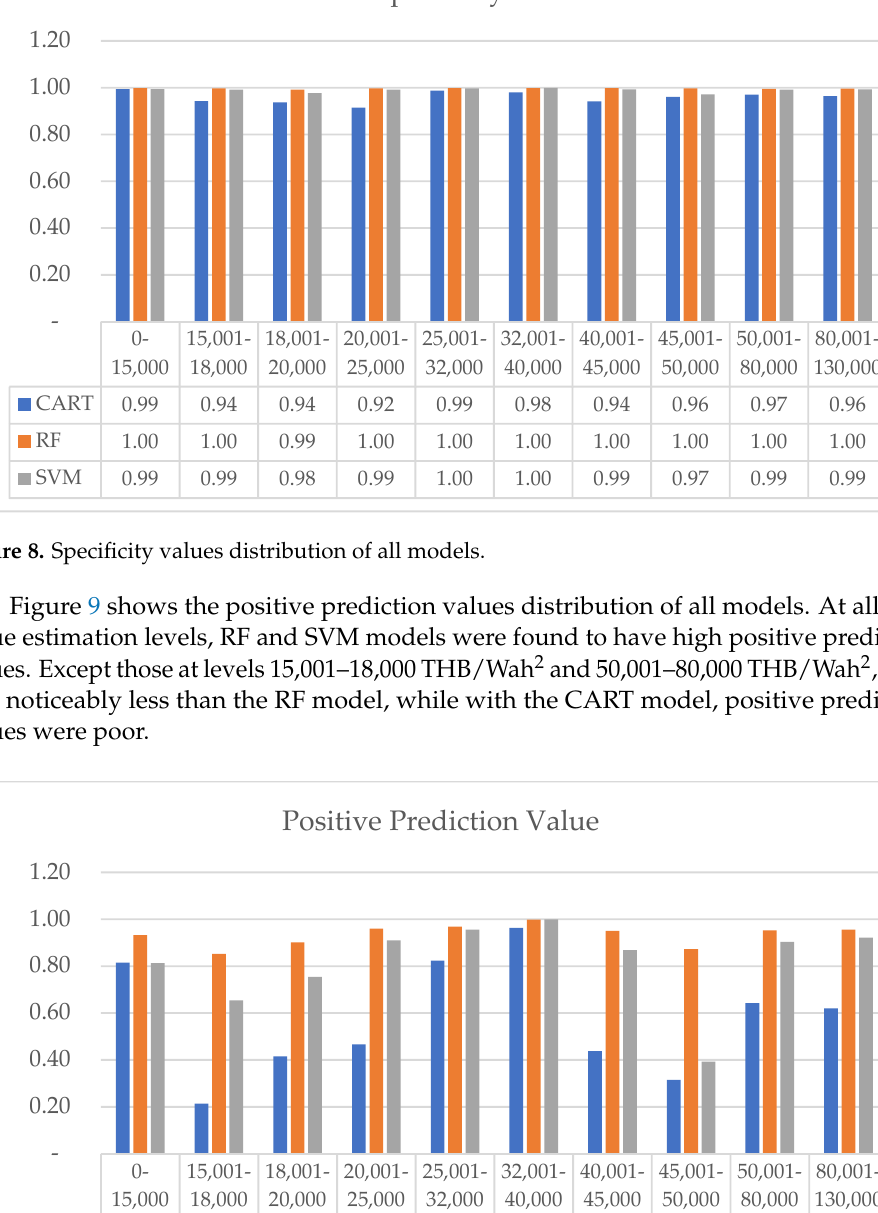
Figure 7. Sensitivity values distribution of all models. Figure 8 shows the specificity values distribution of all models. According to the ta- ble, all models have high specificity values at all land value estimation levels. Specifically, the RF model finds a value equal to 1 at all land value estimation levels.